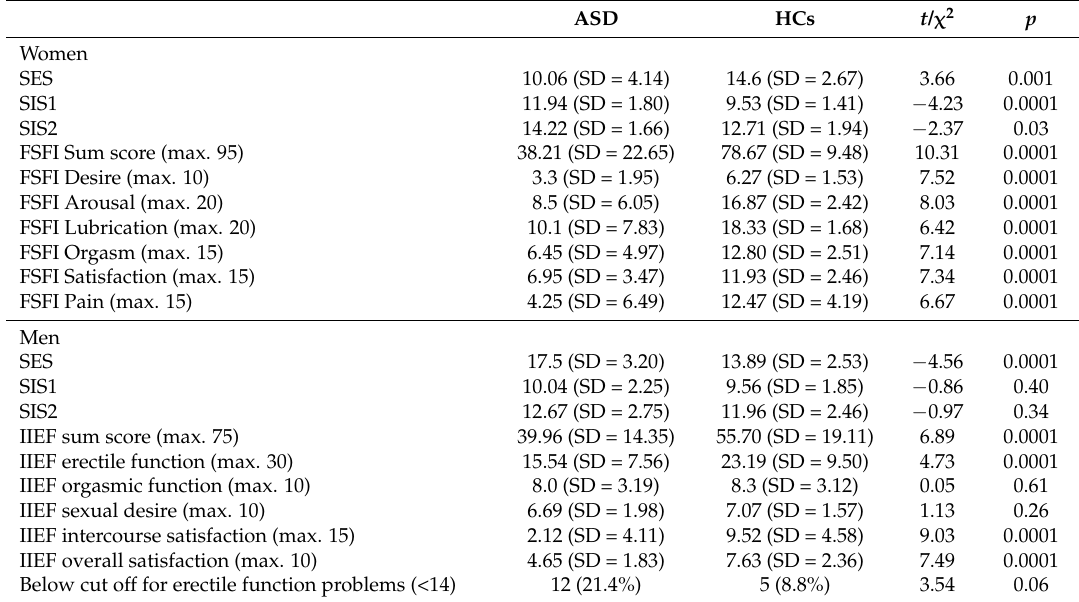
Table 2. Average questionnaire sum and subscale scores compared between autism spectrum disorder (ASD) patients and healthy controls